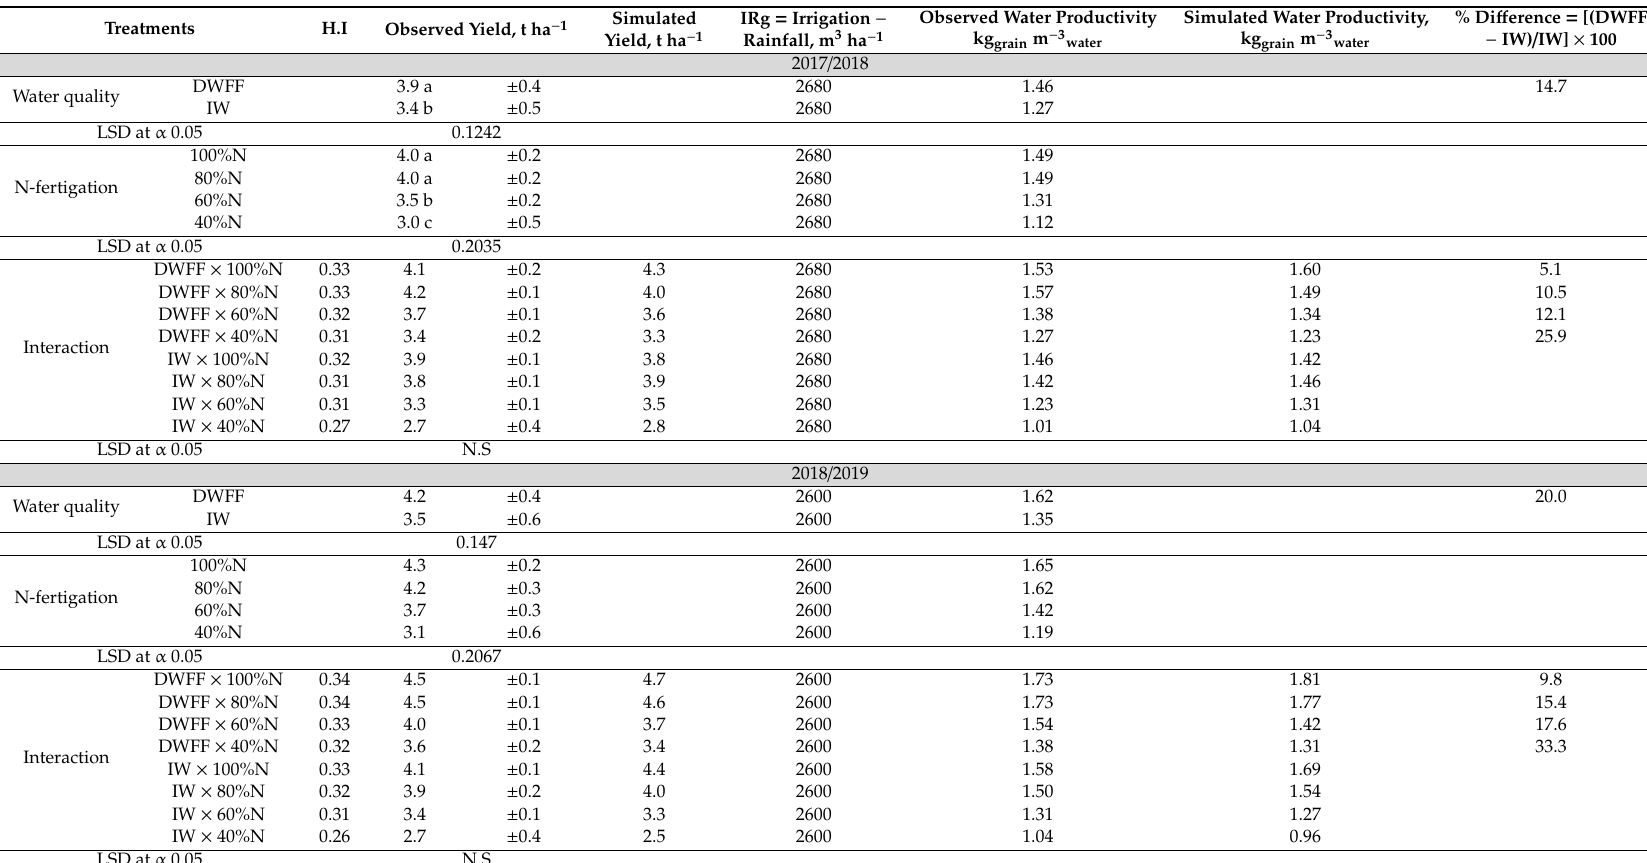
Table 9. E ff ect of the water quality and nitrogen fertigation rate on the Harvest Index, grain yield, and water productivity of